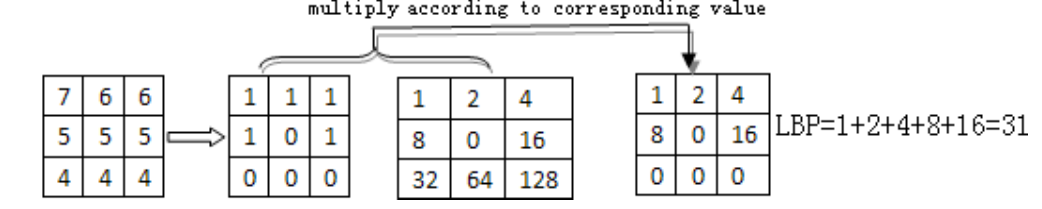
Figure 1. The computational process of local binary pattern (LBP)